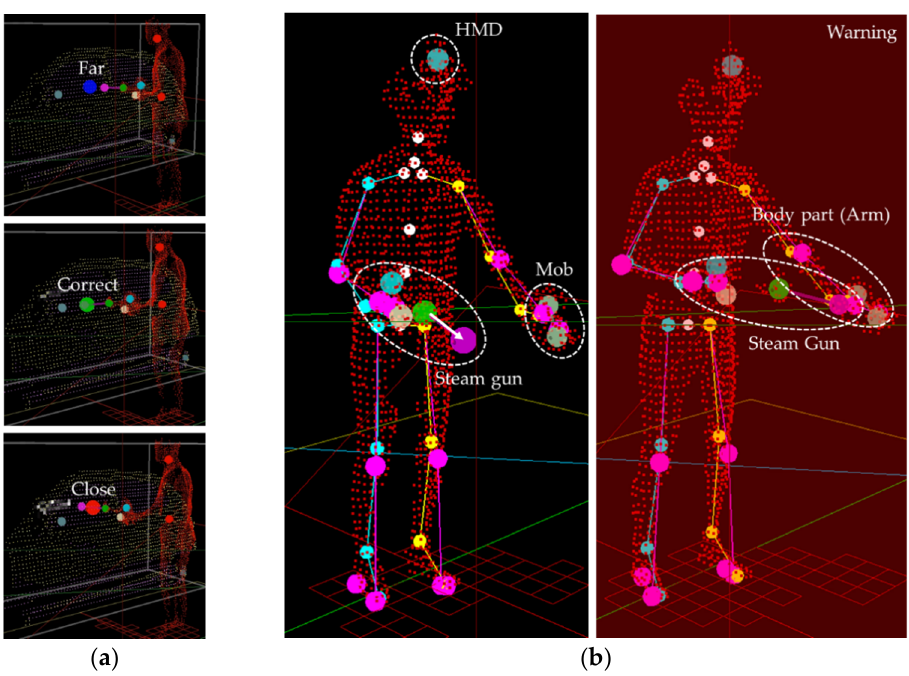
Figure 16. Evaluations of steam spray: ( a ) Distance (blue circle: far, green circle: correct, red circle: close); ( b ) Direction (red warning: dangerous situation).